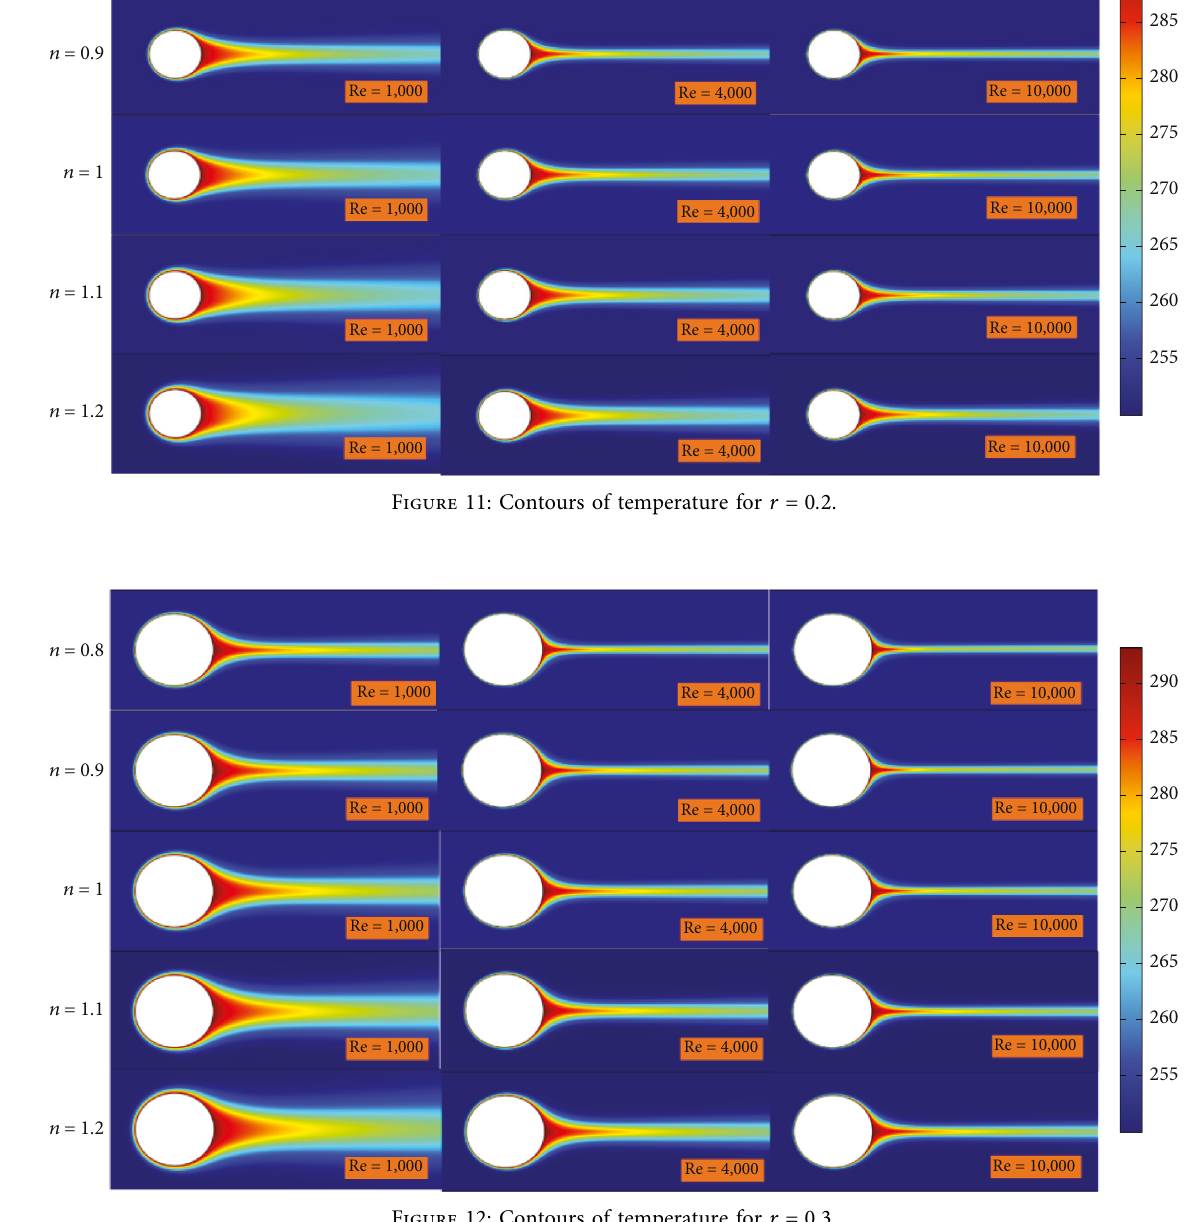
Figure 12: Contours of temperature for r � 0 .